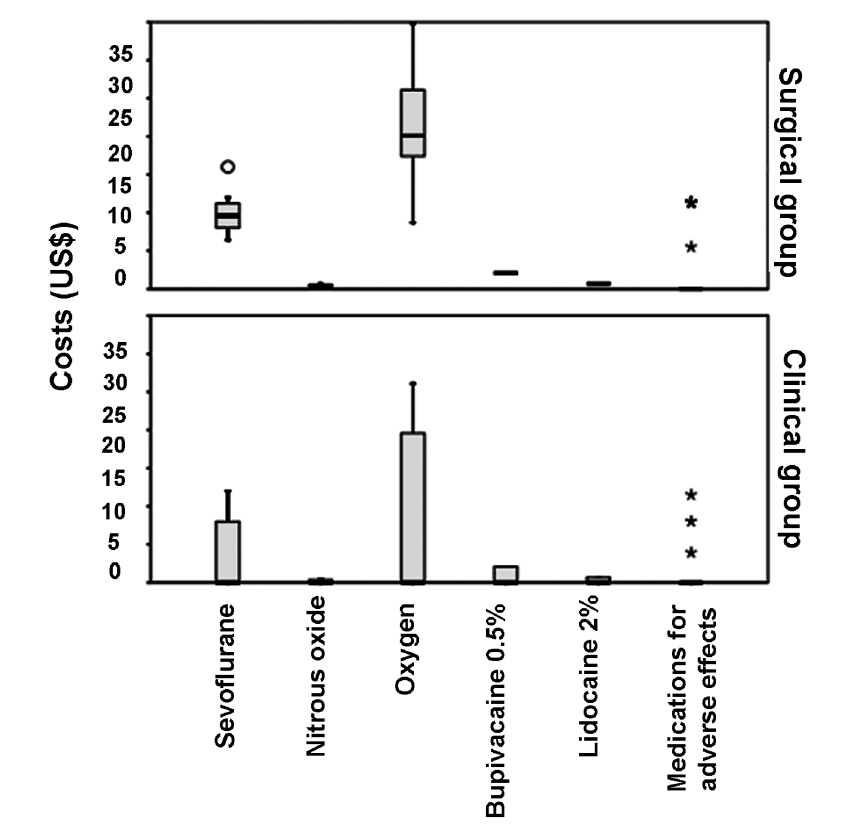
Figure 3 – Box plot of the cost analysis of the parameters investigated in both